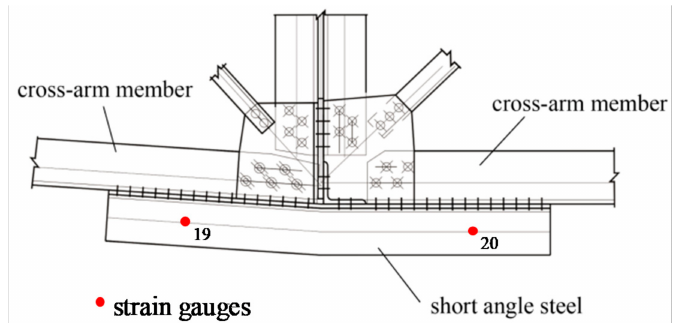
Figure 8. The layout diagram of measuring